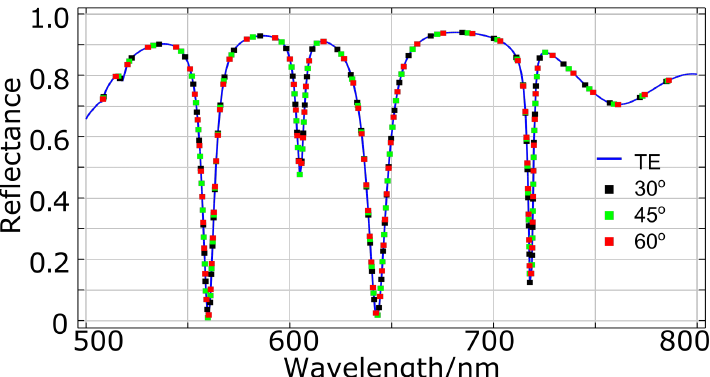
Figure A2. Reflectance spectra of DCIM under normal TE illumination and azimuthal rotated TE